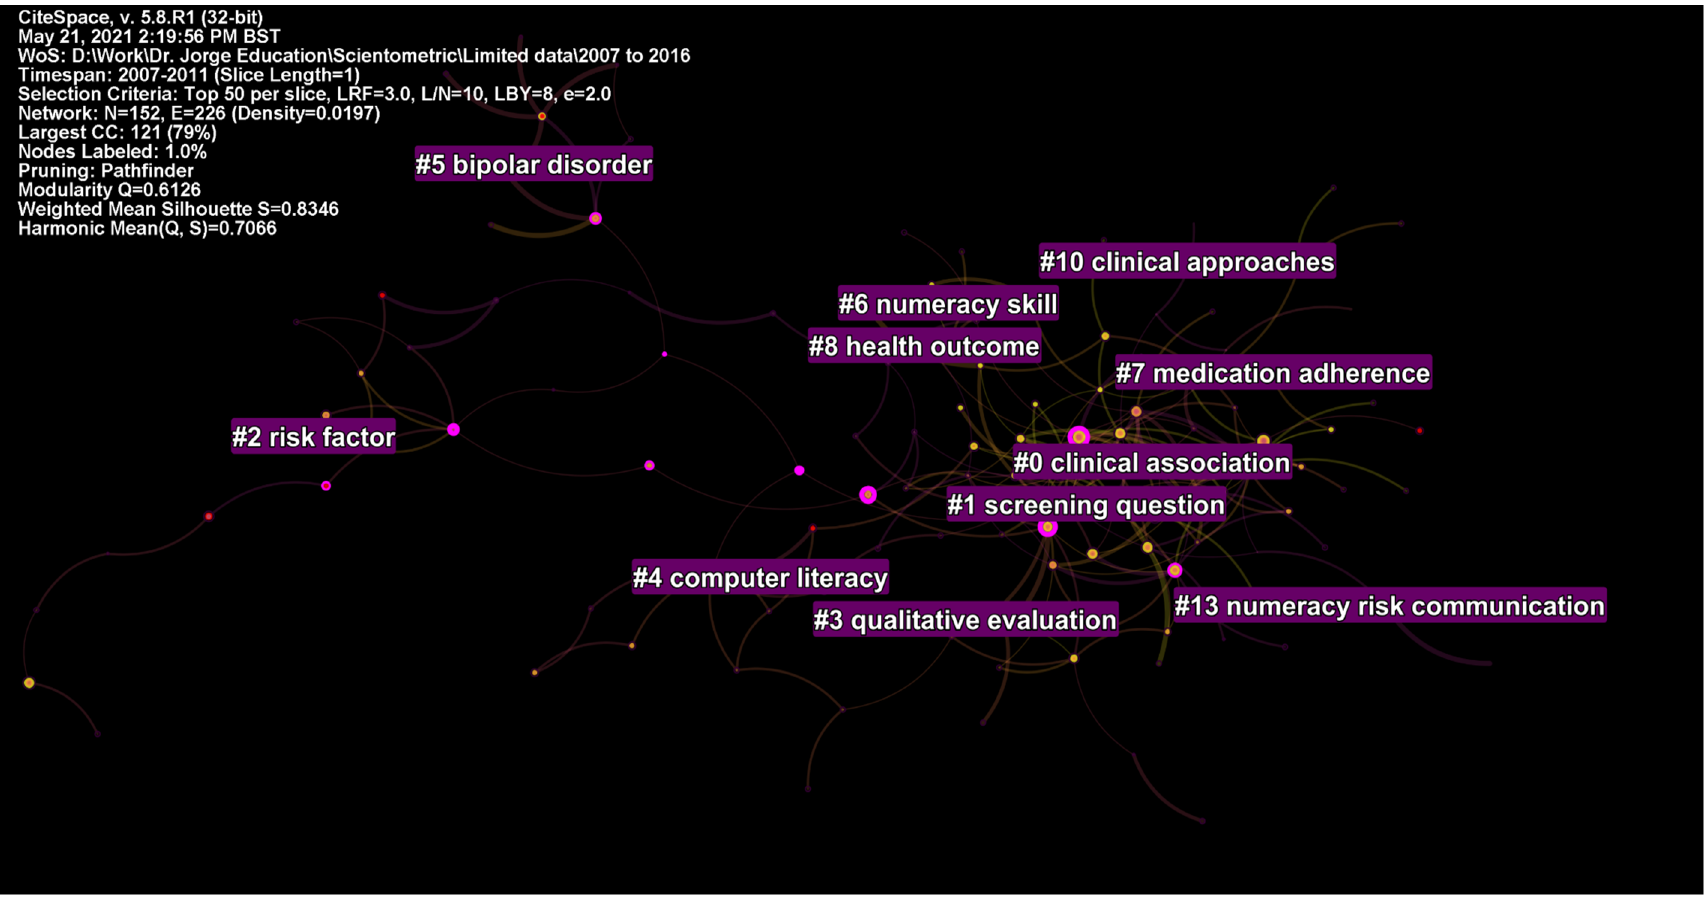
Figure 6. Top clusters of research from 2007 to 2011.